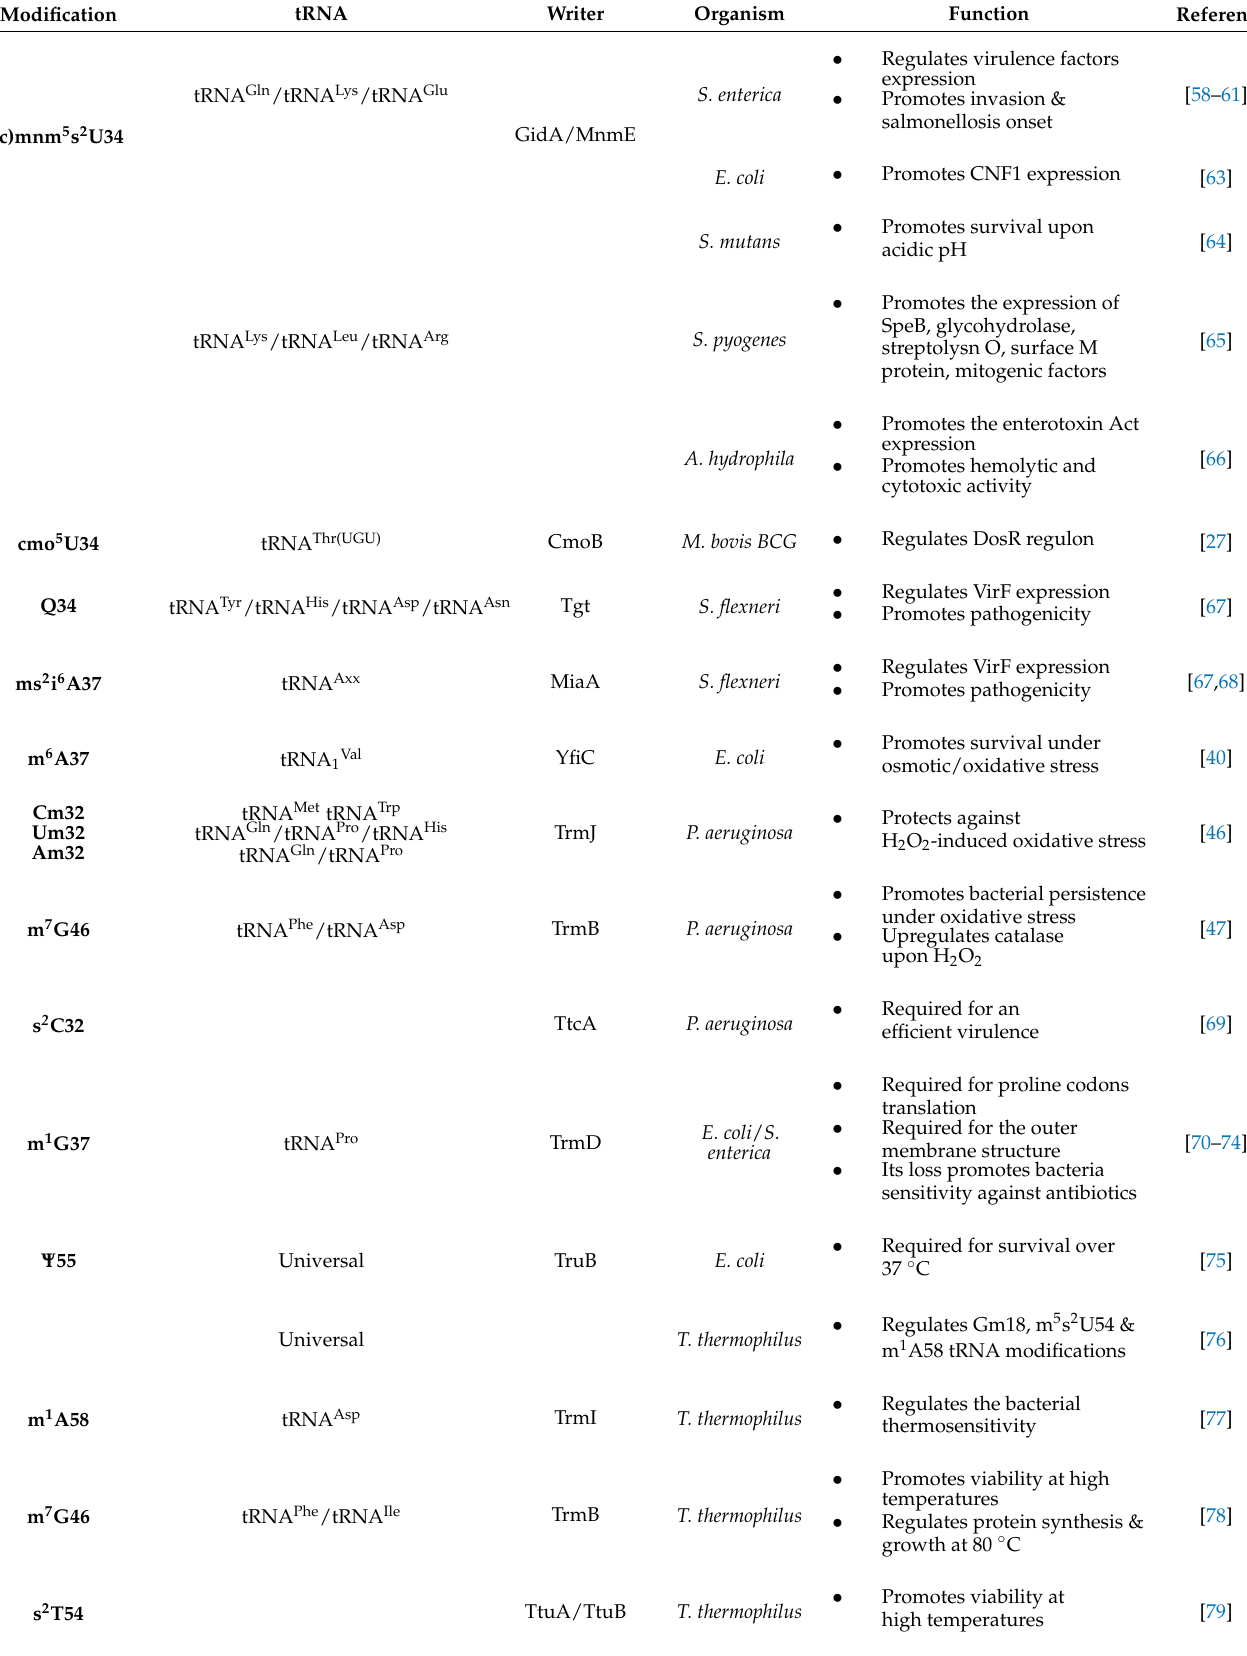
Table 1. tRNA post-transcriptional modifications with a role in bacterial virulence and